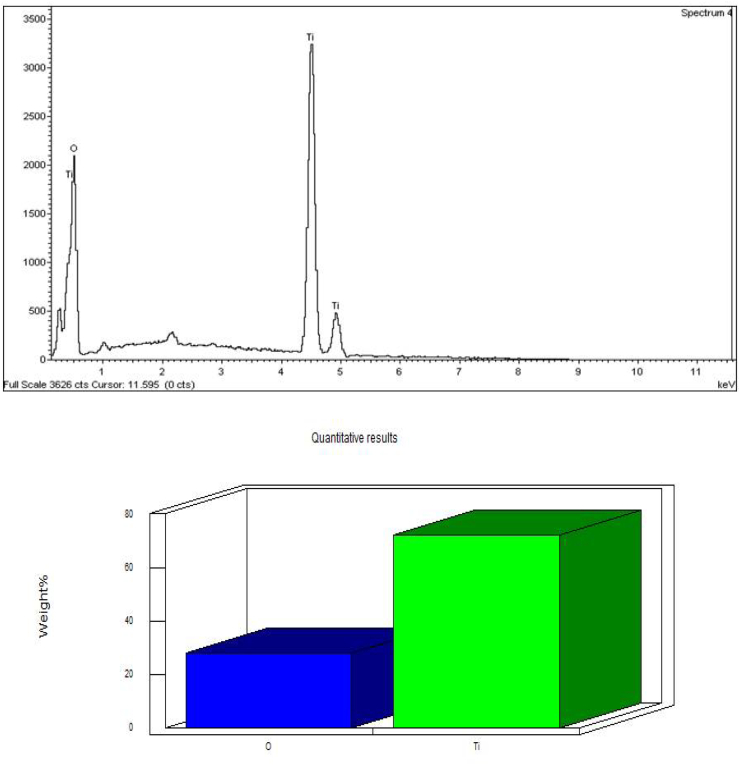
EDX images of synthesized TiO2 NPs.